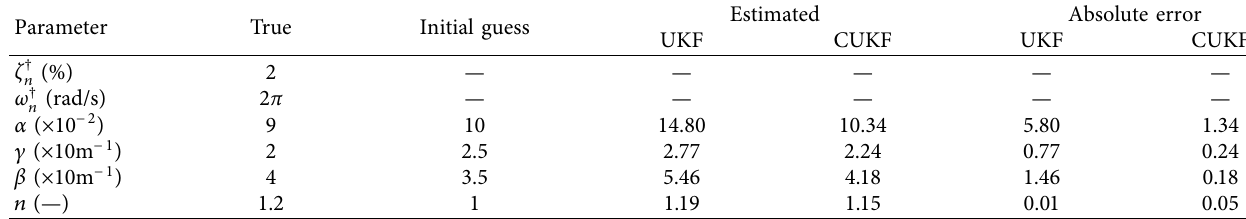
Table 1: Model parameters used in Example 1.